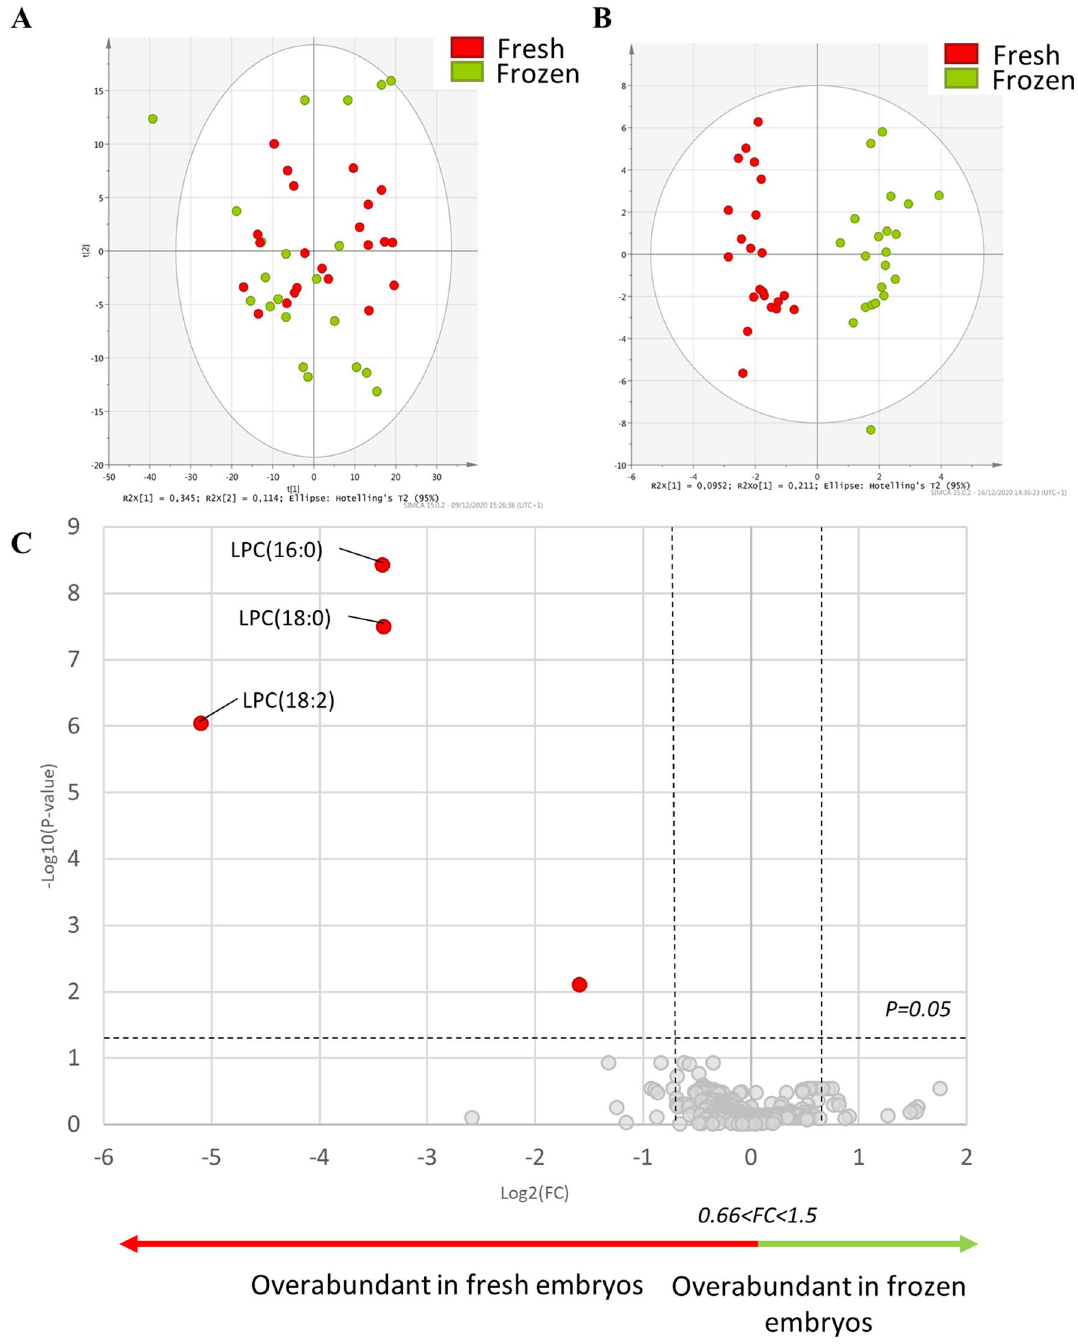
Figure 4. ( A ) Principal component analysis (PCA) plot representing variance among in vitro fresh and frozen embryos according to principal component analysis. The red dots show data for fresh in vitro produced embryos, and the green circles show data for frozen in vitro produced embryos. ( B ) Multivariate analysis by orthogonal partial least square discriminant analysis (O-PLS-DA), discriminating the state before and after freezing ( fresh vs. frozen ) according to the lipid profile of the embryos. ( C ) Univariate analysis via volcano plot based on fold-change and p value, highlighted several lipids. Red dots correspond to significantly different lipids between fresh and frozen in vitro produced embryos, particularly to those overabundant in fresh embryos, while the grey ones represent the non-significant ones. Statistical significance is determined at p < 0.05 and fold- change greater than 1.5 or less than 0.66. Significantly different annotated lysophosphatidylcholine (LPC) are represented on the volcano